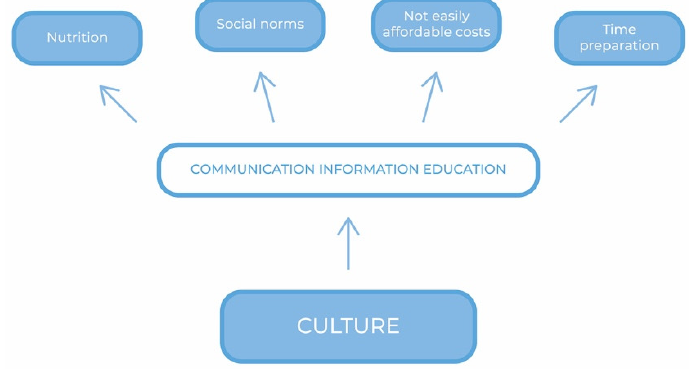
Figure 2. A communication framework of actions.